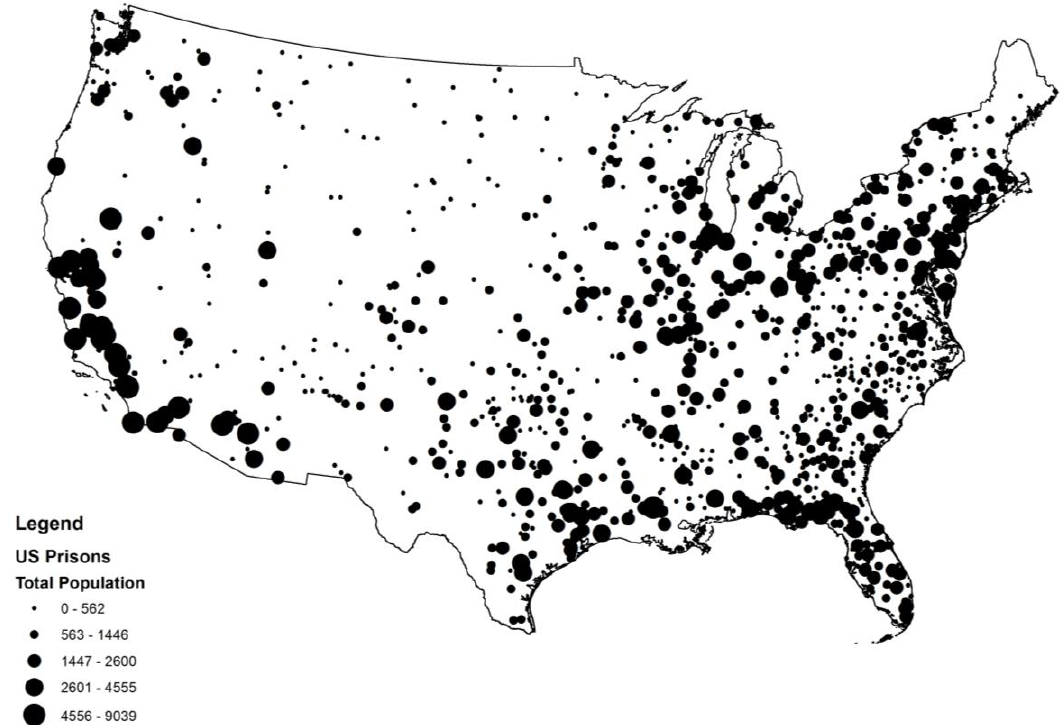
Figure 1. U.S. prison proliferation, 1811–2010. Source: Prison Proliferation Project.